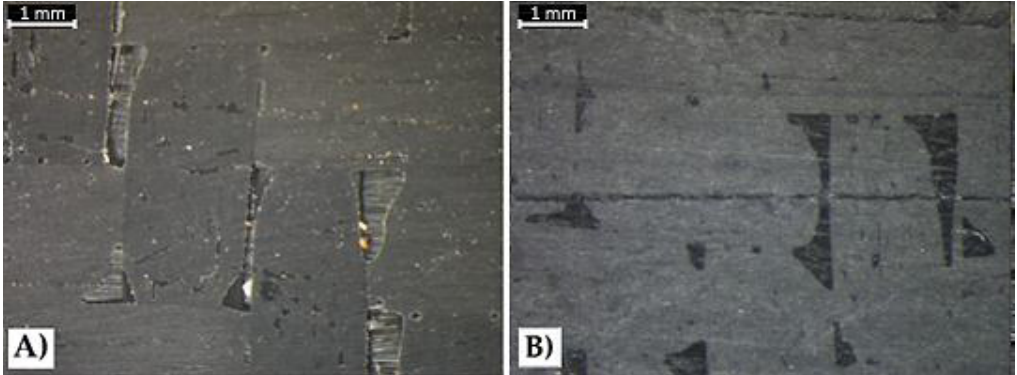
Figure 8. Optical microscope observations of the fracture surfaces of ( A ) carbon fabric reinforced epoxy resin (CFRP) and ( B ) PA12-CR of untreated (UT) specimen after DCB test.